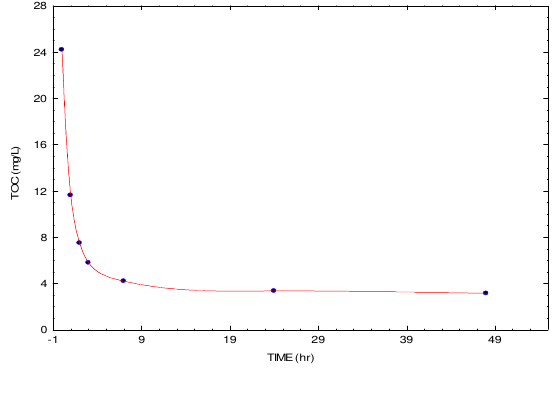
Fig. 1. TOC Pollutant concentration with time at T= 25 o C, pH 7, wastewater/(Algae broth) ratio = 1, and sterilized wastewater.